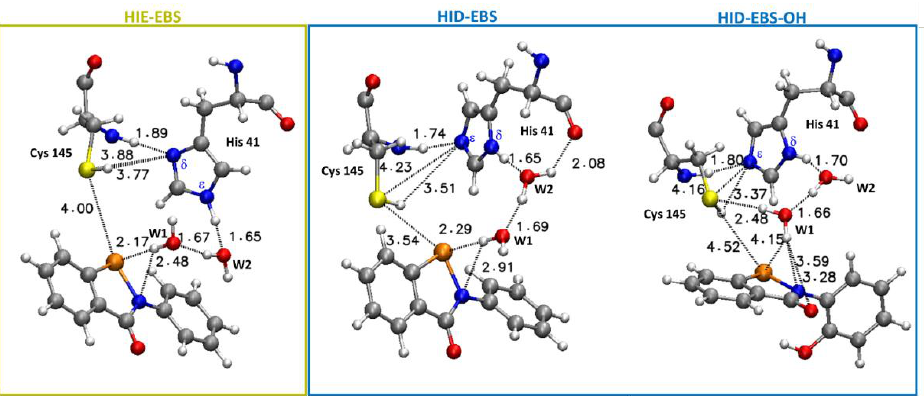
Figure 4. Structure and main distances (in Å ) between atoms of the M pro active site and EBS in the EI complex for both HIE (in yellow box) and HID forms and between atoms of the M pro active site HID and EBS-OH (in blue box) optimized at the B3LYP-D3/6-31+G (2d,2p) level. For clarity, only a small part of the model is shown. For the full model, see Figure 3.